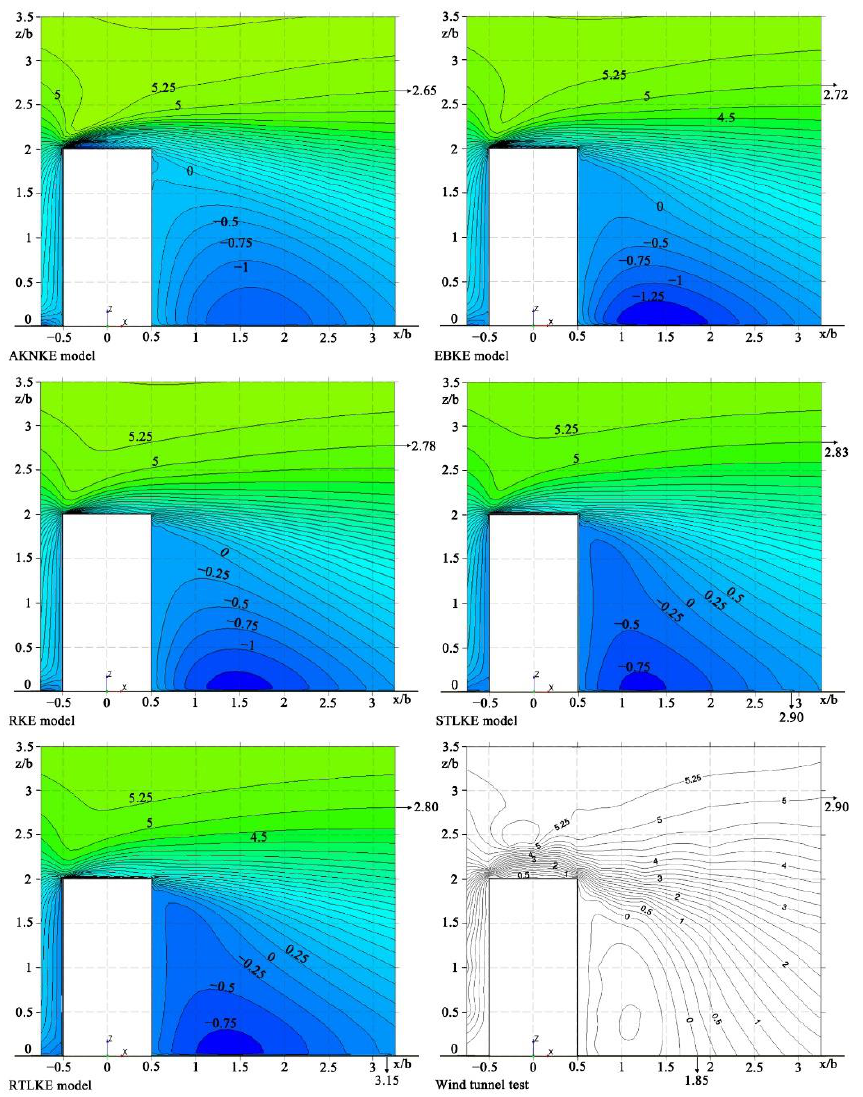
Figure 9. Contour plots of X-velocity ( U ) at Y = 0.